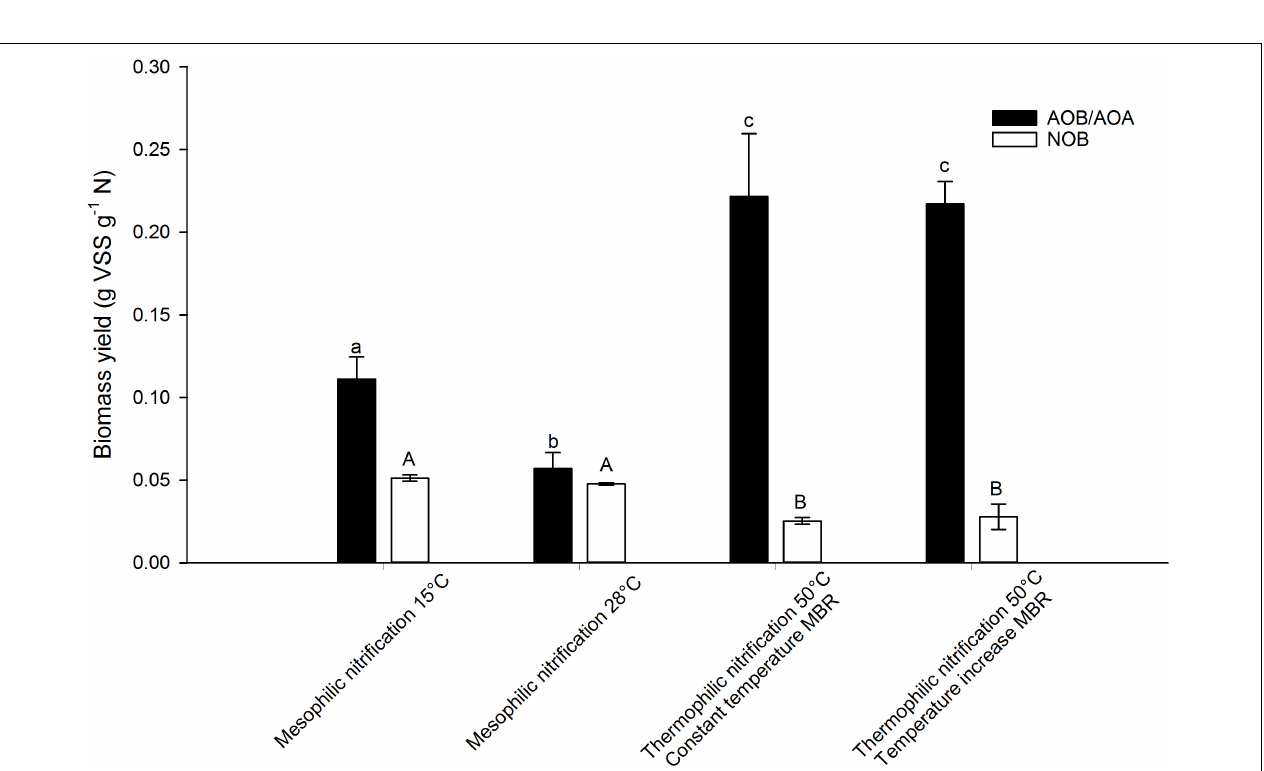
FIGURE 3 | AOB/AOA and NOB yield of a mesophilic nitrifying inoculum at 15 and 28 ◦ C and of two thermophilic nitrifying communities at 50 ◦ C, determined based on the incorporation of 13 C. Error bars represent the standard deviation of triplicate incubations with the same inoculum (technical replicates). Significant pairwise differences ( p < 0.05) of AOB/AOA yield are indicated with different non-capital letters, significant pairwise differences ( p < 0.05) of NOB yield are indicated with different capital letters.